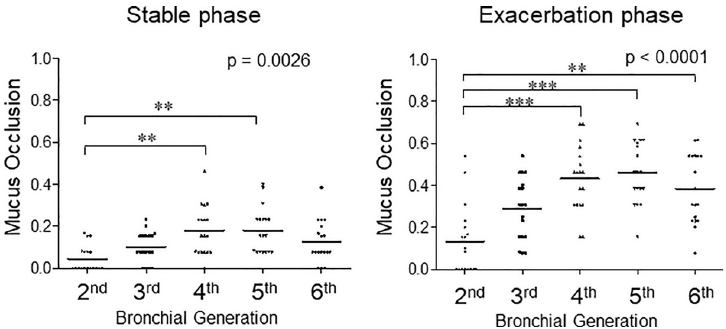
Fig 4. The ratio of mucus-occluded bronchial compartments in 13 subjects by airway generation during asthma exacerbation and the stable phase. Mucus occlusion (mucus plug) was measured by HRCT using curved MPR software. Mucus plugs are defined as the complete occlusion of a bronchus, contiguous with patent airway lumen on longitudinal airway image. Mucus occlusions are counted per airway generation in all segments of the lung for each subject. Each point represents the ratio of mucus-occluded compartments in 13 patients for each segment.